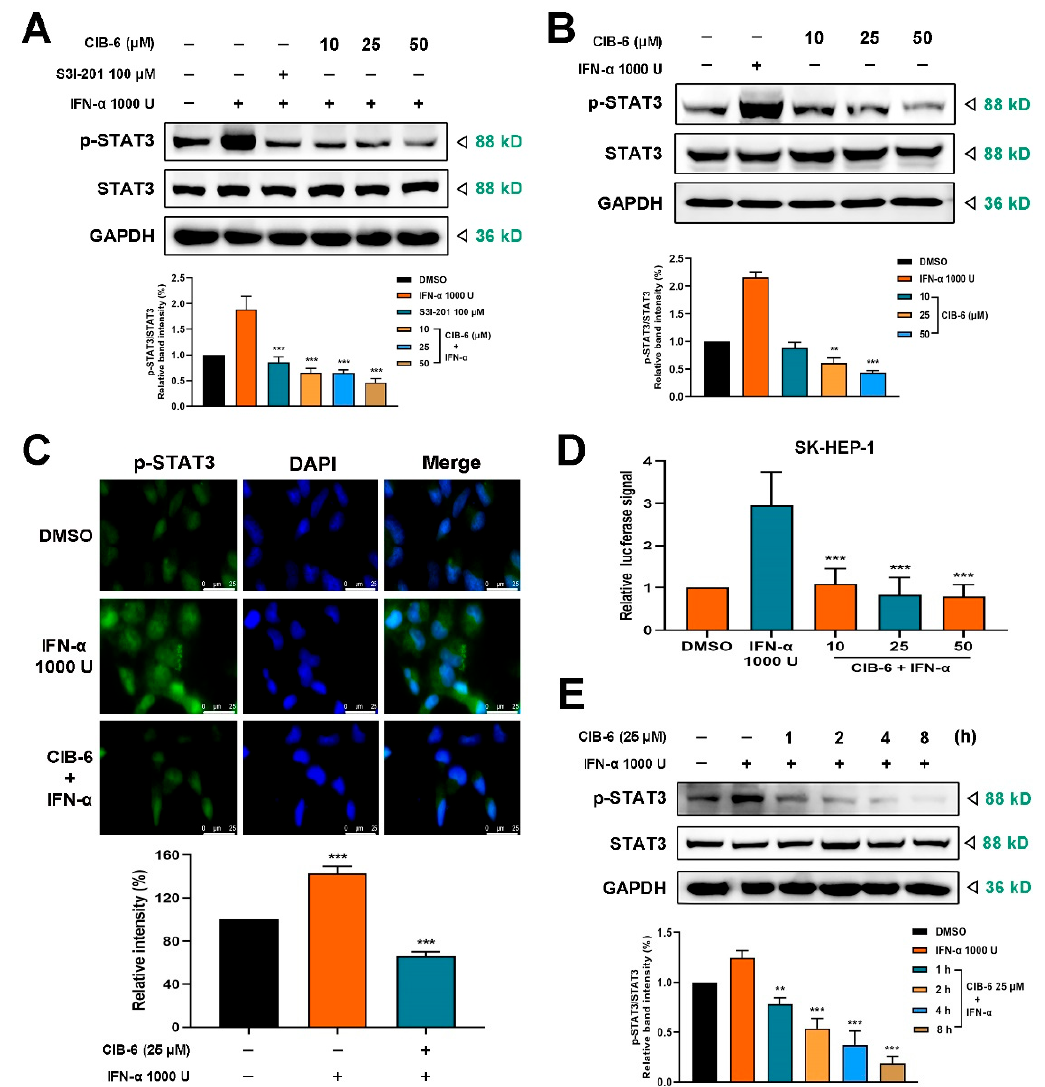
Figure 2. CIB-6 inhibits IFN- α induced STAT3 phosphorylation. The SK-HEP-1 cells were treated with the indicated concentrations of CIB-6 for 24 h and 1000 U/mL IFN- α for 0.5 h. ( A ) The cell lysates were immunoblotted with antibodies against phosphorylated and total proteins of STAT3. The STAT3 inhibitor, S3I-201 (100 µ M, treat for 24 h), was employed as the positive control. Bar graph shows quantified levels of p-STAT3/STAT3 from three independent experiments (*** p < 0.001 as compared with IFN- α ). ( B ) The cell lysates were immunoblotted with antibodies against phosphorylated and total proteins of STAT3 after treated with the indicated concentrations of CIB-6 for 24 h alone. Bar graph shows quantified levels of p-STAT3/STAT3 from three independent experiments (** p < 0.01 and *** p < 0.001 as compared with DMSO). ( C ) The SK-HEP-1 cells were fixed and analyzed via an immunofluorescence assay ( × 100). The fluorescence intensity was quantified using ImageJ; data are presented as mean ± SD of triplicate experiments. *** p < 0.001 indicates significant differences relative to the vehicle-treated control group. ( D ) After SK-HEP-1 cells were transfected with the pGL4.26-3 × STAT3 plasmid, luciferase repression of CIB-6 treated cells compared to the control or IFN- α was calculated and plotted as a fold change in luciferase activity. The luciferase of the empty vehicle was used to normalize the luciferase values. The data are presented as mean ± SD of three independent experiments (*** p < 0.001 as compared with IFN- α ). ( E ) The SK-HEP-1 cells were treated with 25 µ M CIB-6 for the indicated period. Thereafter, immunoblotting was performed to detect the phosphorylated STAT3 expression and total proteins of STAT3 after IFN- α induction. GAPDH was used as an internal control. Bar graph shows quantified levels of p-STAT3/STAT3 from three independent experiments (** p < 0.01 and *** p < 0.001 as compared with IFN- α